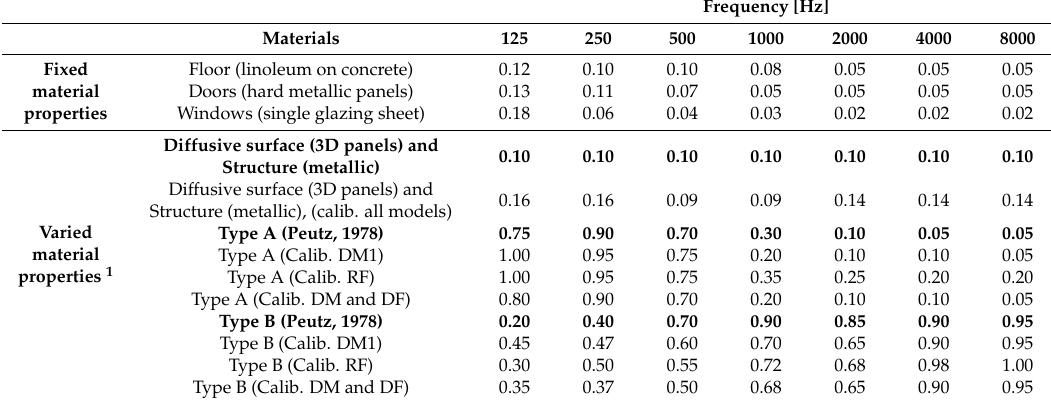
Table 1. Absorption coefficients assigned to the different surfaces of the hall. “Fixed materials properties” have not been varied during the calibration process. Materials in the group of “Varied material properties” have been modified starting from the values signed in bold to the gray